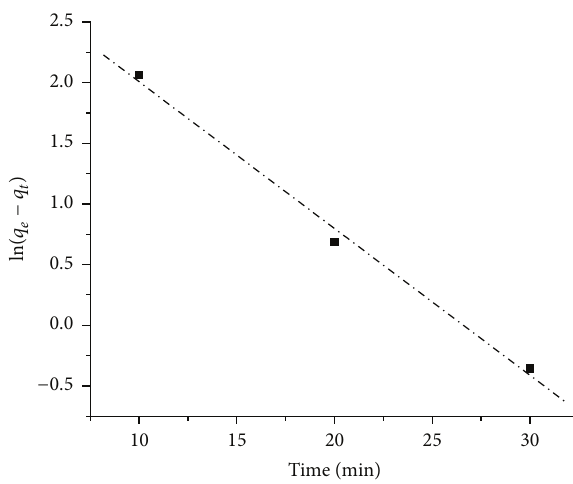
Figure 10: Lagergren plot for the adsorption of Hg(II) ions by ALP biomass at pH 6.